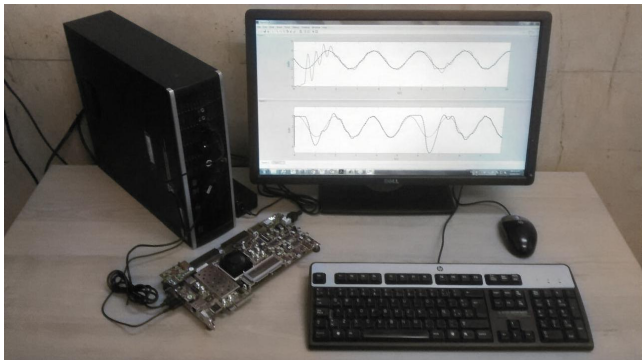
Figure 3. Real-time implementation of the control system using hardware-in-loop (HIL) architecture.